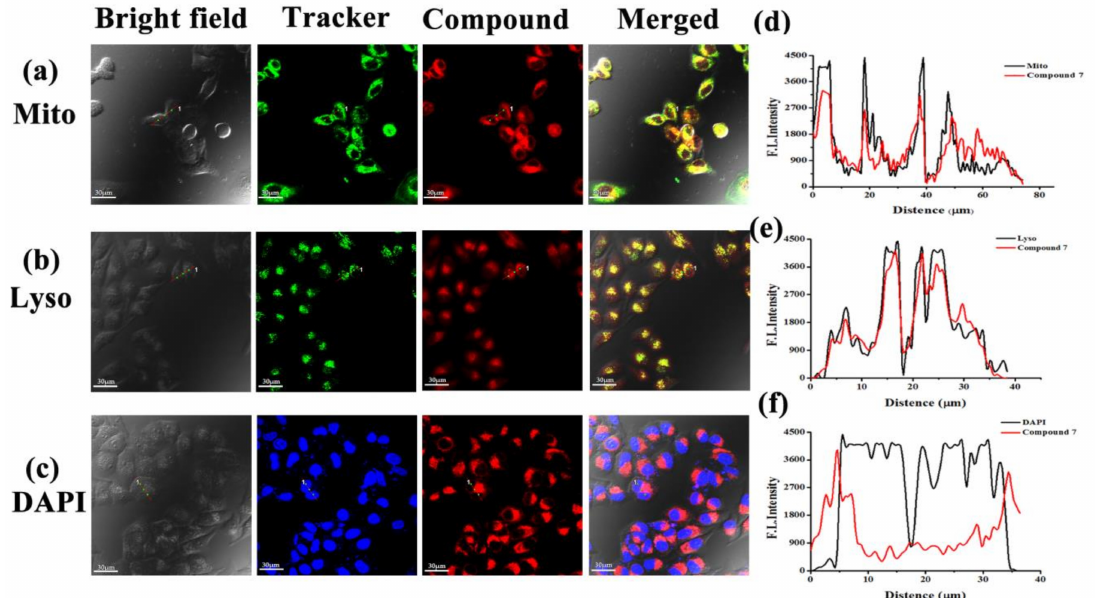
Figure 12. Visualization of the intracellular fluorescence of HeLa cells for Mito-Tracker Green (in green, a ), Lyso-Tracker (in green, b ), DAPI (in blue, c ), and compound 7 (in red, 5 µ M). Fluorescence intensity profiles of DAPI ( d ), Mito-Tracker Green ( e ), Lyso-Tracker ( f ), and compound 7 (5 µ M) traced along the red line in ( a , b , c